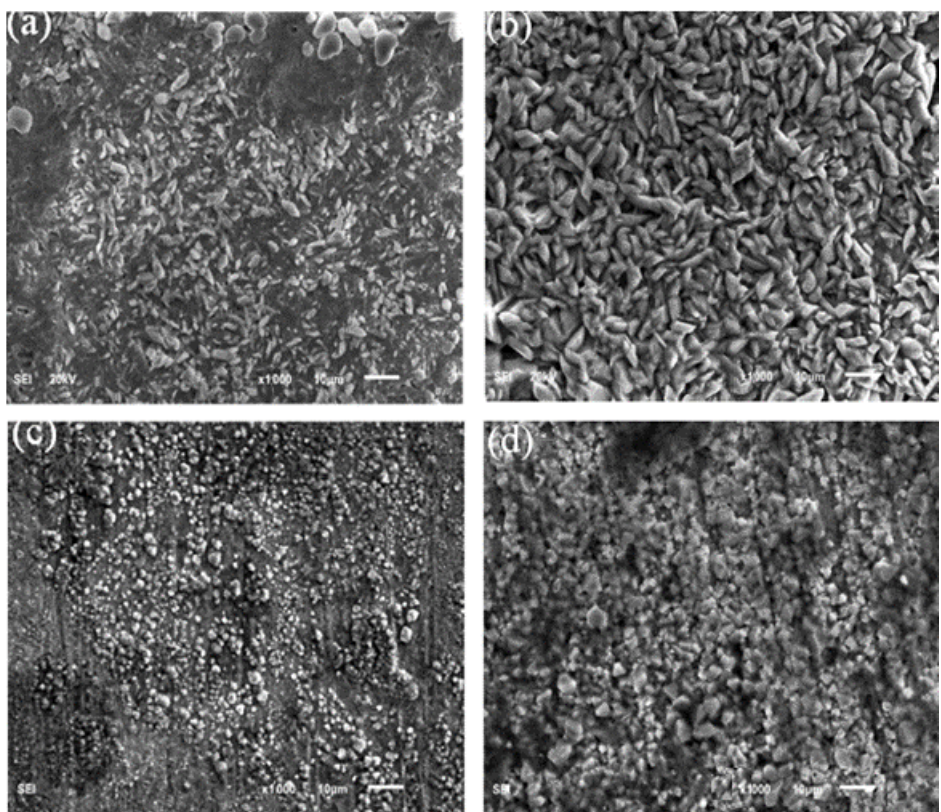
Figure 9. SEM images of copper samples under two different corrosive environmental fluids: ( a ) Formic acid,15 d; ( b ) Formic acid,30 d; ( c ) Acetic acid,15 d; ( d ) Acetic acid, 30 d.